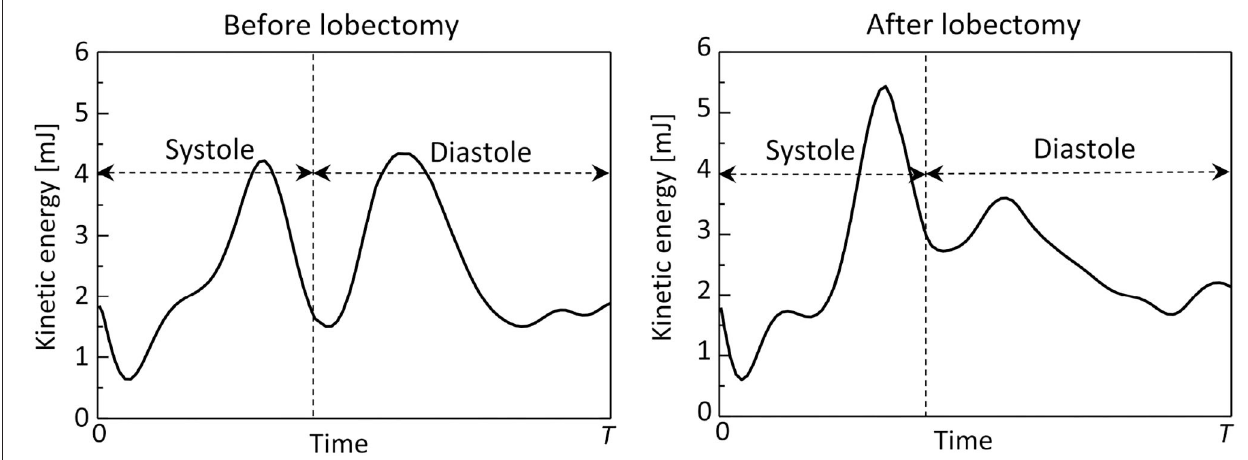
FIGURE 8 | Time courses of the flow kinetic energy in the left atrium throughout the cardiac cycle, before and after the left upper lobectomy ( T : cardiac cycle from early systole).